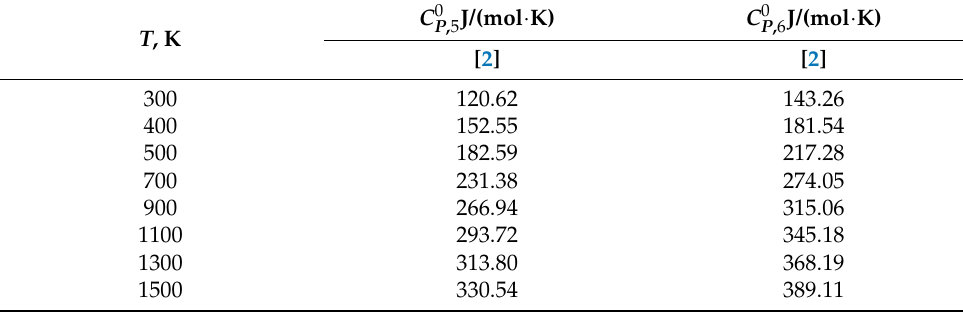
( T ) of n -C 5 H 12 and n -C 6 H 14 P